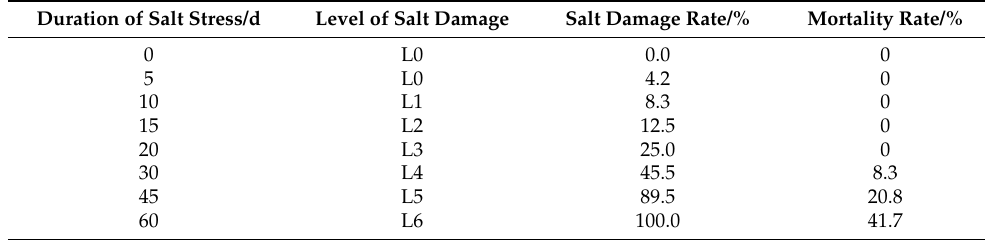
Table 1. Grade of salt damage changed with elongation of salt stress in seedlings of C. hongkongensis subsp. tonkinensis